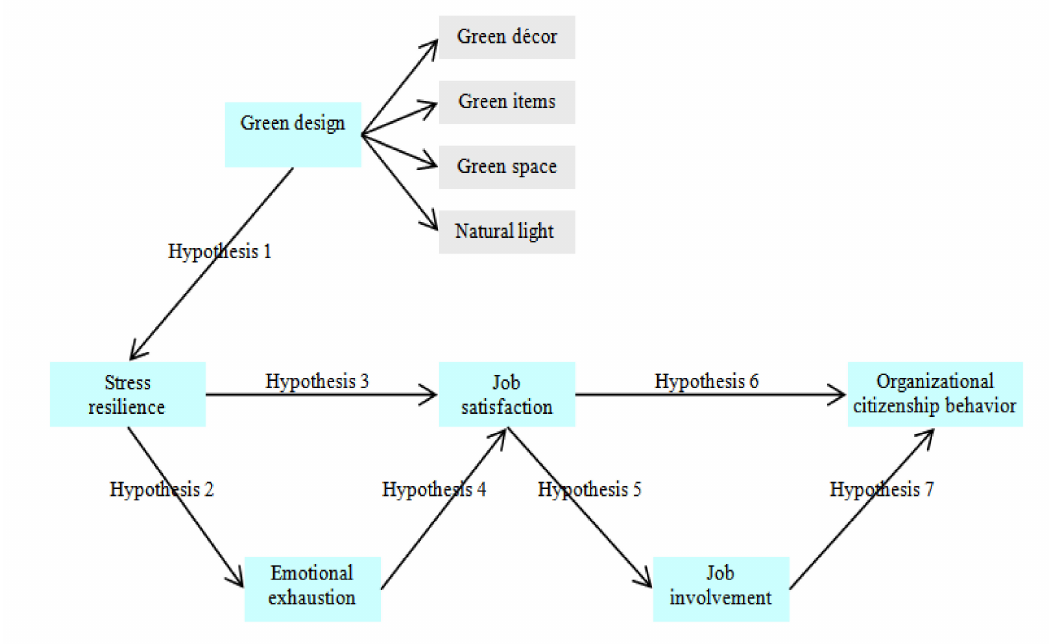
Figure 1. Proposed model and the research